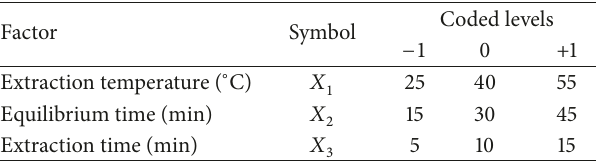
Table 1: Experimental factors and their coded and actual values used for HS-SPME optimization using response surface methodol-